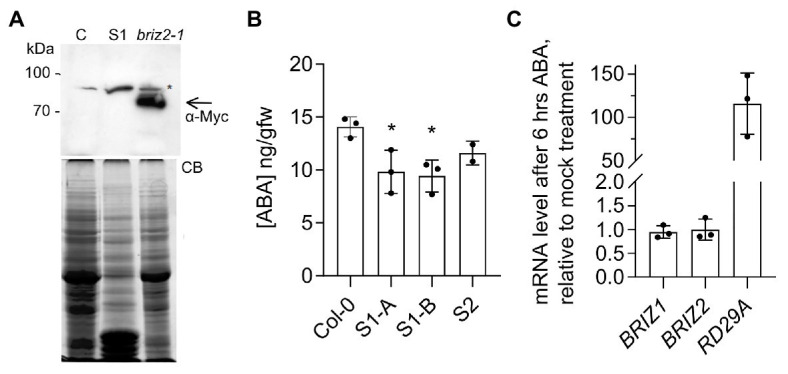
briz seeds do not hyper-accumulate ABA, and ABA does not affect BRIZ mRNA levels. (A) Anti-Myc immunoblot of extracts from 24 h imbibed seeds from untransformed control Col (left), a complemented briz2-1 line expressing Myc-BRIZ2 with a wild-type phenotype (right), and the homozygous S1 briz2-1 line with the silenced Myc-BRIZ2 transgene, whose progeny failed to germinate (S1, middle lane). Below, total protein staining with Coomassie blue (CB). Asterisk denotes a non-specific immunoreactive band. Arrow denotes position of Myc-tagged BRIZ2. (B) ABA content [ng/gm fresh weight GFW)] in 1 h imbibed seeds from wild-type (Col) and two silenced lines (S1 and S2) derived from independent T1 briz2-1 Myc-BRIZ2 transgene-containing complementation lines (Hsia and Callis, 2010). S1-A and S1-B represent siblings of same initial transformation event. Mean of three replicates except for S2, which was measured twice, ±SD. ANOVA was performed for S1 compared to Col (GraphPad Prism, with Tukey’s multiple comparisons test). (C) Expression of BRIZ1, BRIZ2, and RD29A mRNAs after 6 h of ABA or mock treatment as assayed by quantitative RT-PCR normalized to UBQ10. Results are shown as mean ± SD (n = 9) from three independent experiments. RD29A serves as a positive control for ABA response.